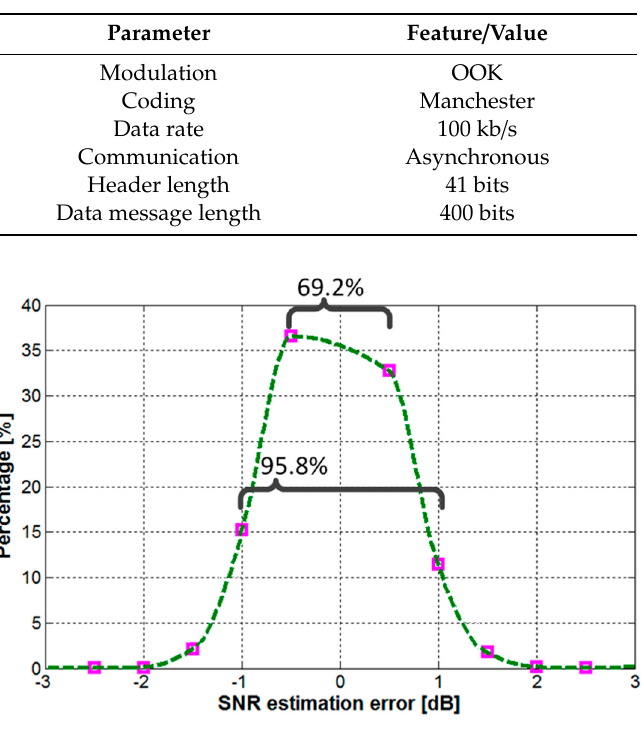
Figure 3. Distribution of the signal to noise ratio (SNR) assessment error at variable SNR levels between 7–15 dB.